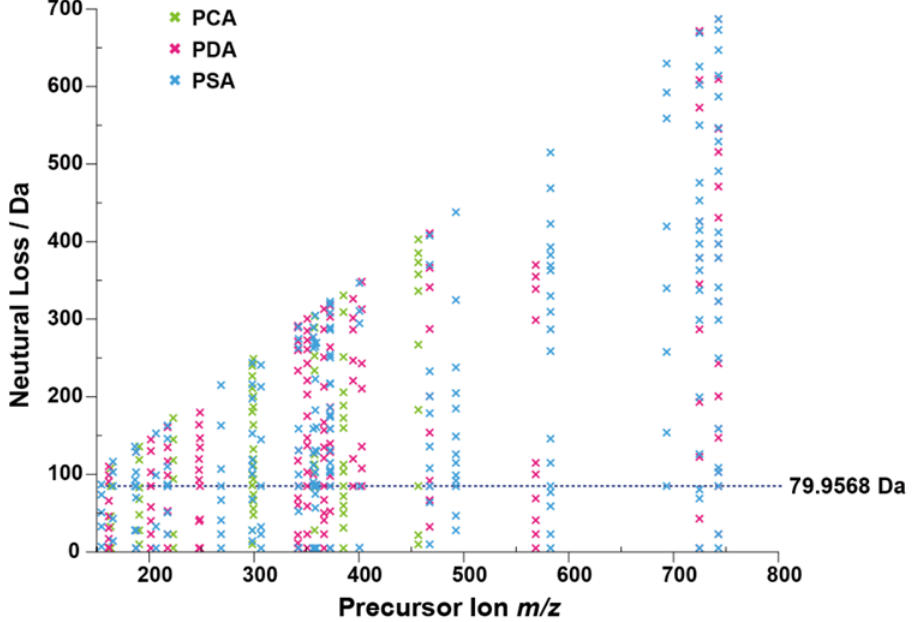
Figure 2. Neutral loss filtering of SO 3 for sulfated products .